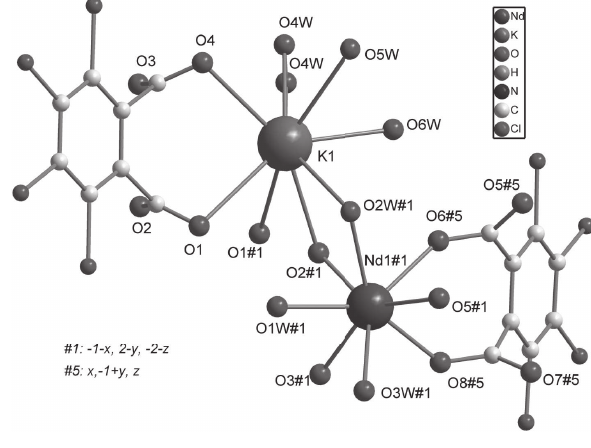
Table 1: Data collection and handling.